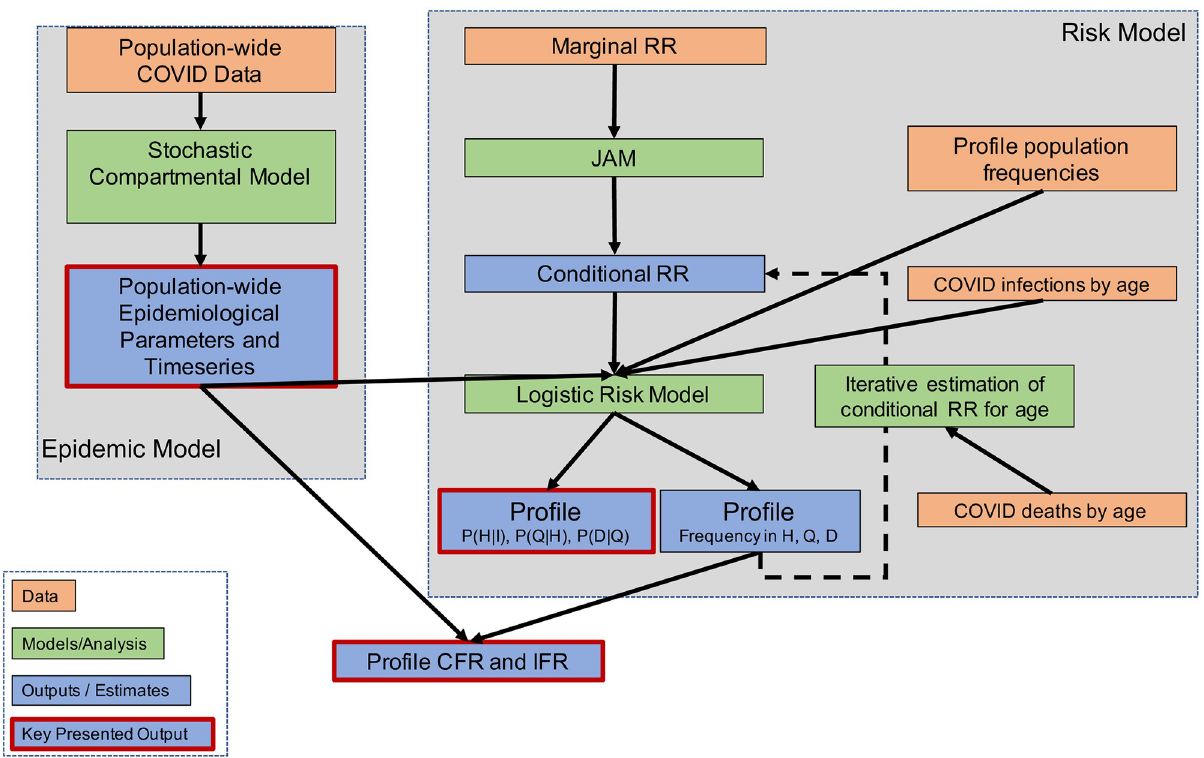
Fig 2. Flow diagram illustrating the risk model , i.e. the set of steps used to produce estimates of risk profile -stratified probabilities of disease progression and CFR and IFR. The diagram shows data inputs, modeling or analysis steps, and outputs or estimates.